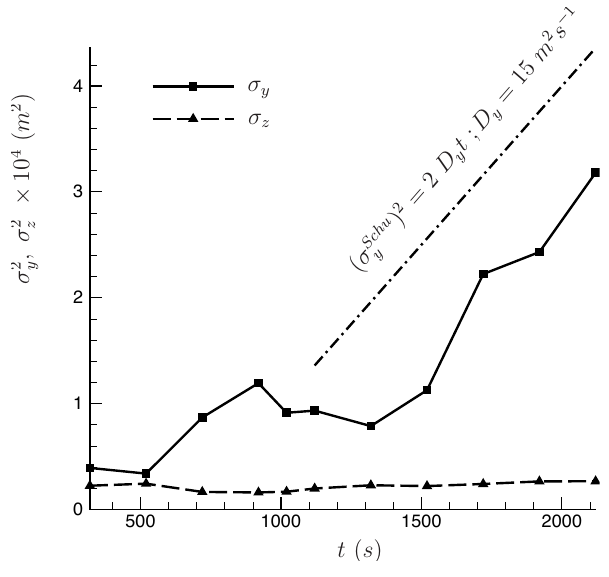
Fig. 15. Evolution of contrail horizontal σ y and vertical σ z spreads during the late dissipation regime. The dash-dotted line indicates the horizontal spreads of a Gaussian plume (Schumann et al., 1995) with fitted diffusion coefficient, D y ’ 15 m 2 s − 1 ( D z ’ 0 ).